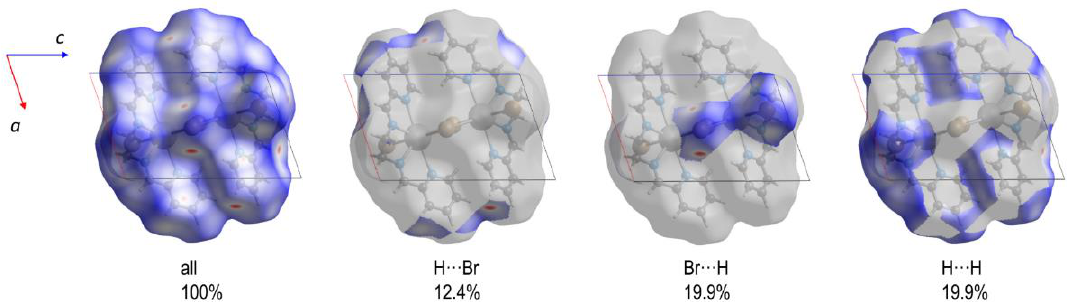
Figure 11. Hirshfeld surface of the dinuclear molecule of 3 highlighting regions of specific interac- tions. Table 4. Electron density at the H···Br BCP and respective binding energies for selected intermolec- ular contacts in the structure 3 [a] .